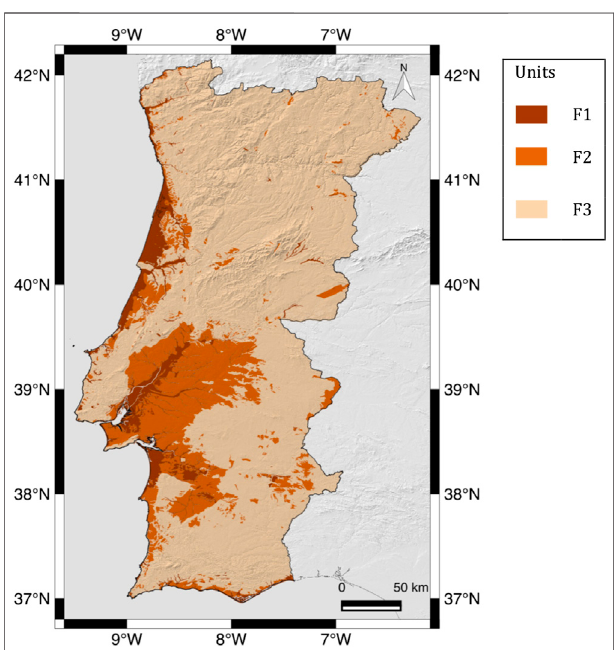
FIGURE 9 | Site conditions map used for scenario calculations: F1 Vs30(mean/P50) (cid:1) 829 m/s, 68%CI [523 m/s, 1315 m/s]; F2